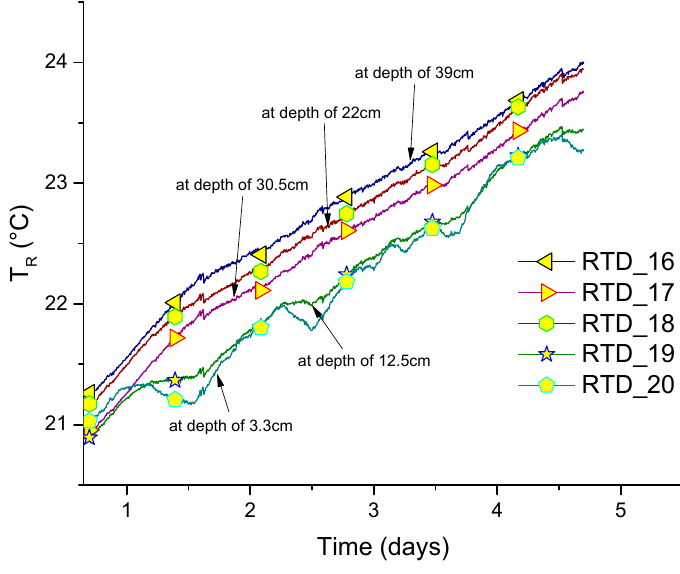
Figure 6. Time-history of the temperature on the right side of the pile.